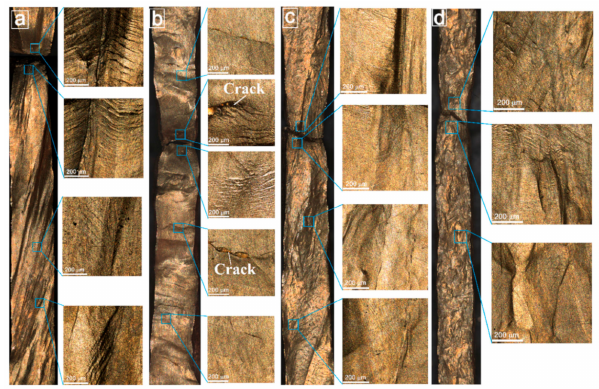
Figure 12. Deformation surface morphologies after tensile tests of as-grown samples 1 ( a ) and 2 ( b ), annealed sample 3 ( c ) and pre-deformed and annealed sample 4 ( d